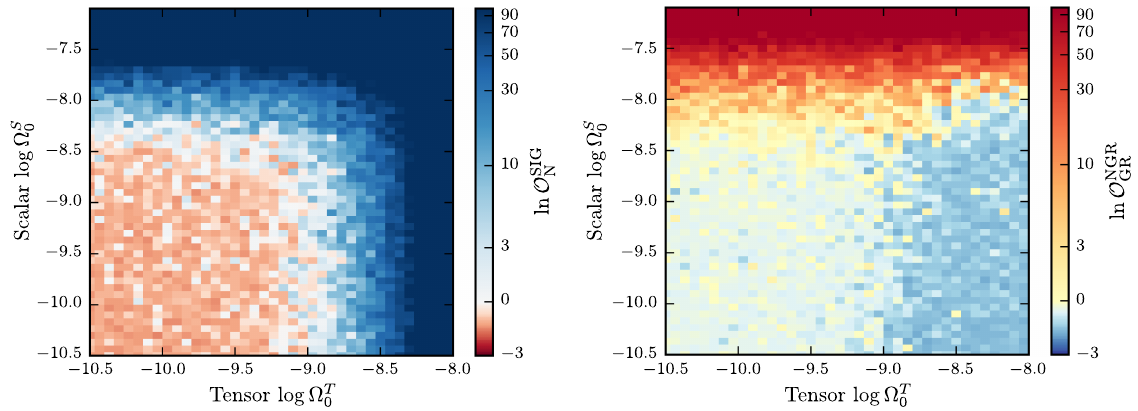
FIG. 8. Odds ratios for simulated Advanced LIGO measurements of stochastic backgrounds containing both tensor and scalar polarizations, assuming 3 years of observation at design sensitivity. The tensor and scalar components have slopes α T ¼ 2 = 3 and α 0 , respectively. Left: Odds ratios between signal and noise hypotheses. The observed values of O SIG S ¼ background energy. Thus, the detectability of a background depends largely on its total power, not its polarization content. Right: Odds ratios O NGR between NGR and GR hypotheses. Advanced LIGO would confidently identify the presence of the scalar background GR component when log Ω S 0 ≳ − 7 . 9 . LIGO ’ s sensitivity to the scalar component is nearly independent of the strength of the tensor component; the minimum identifiable scalar amplitude Ω S 0 rises only slightly with increasing Ω T 0